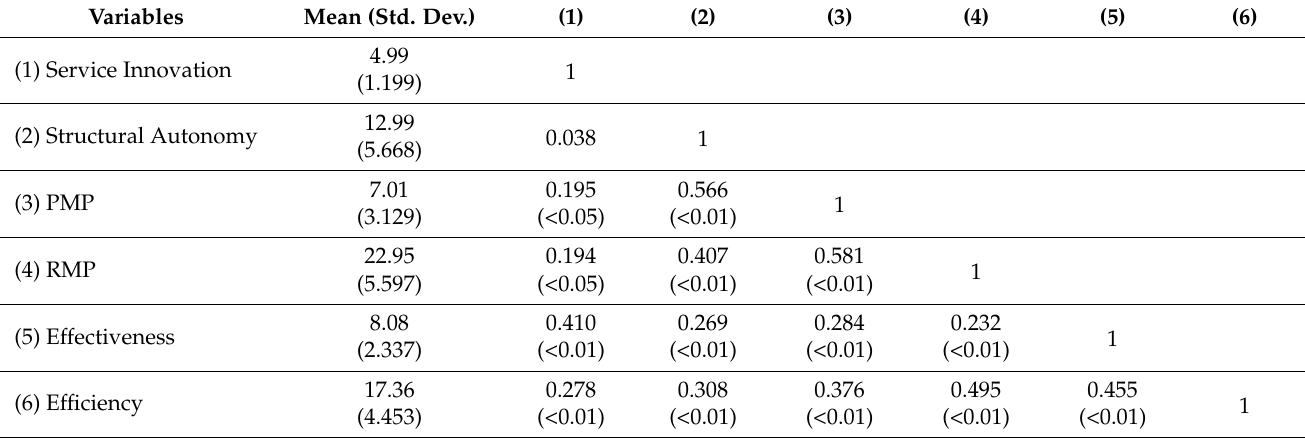
Table 1. Descriptive Statistics and Correlation